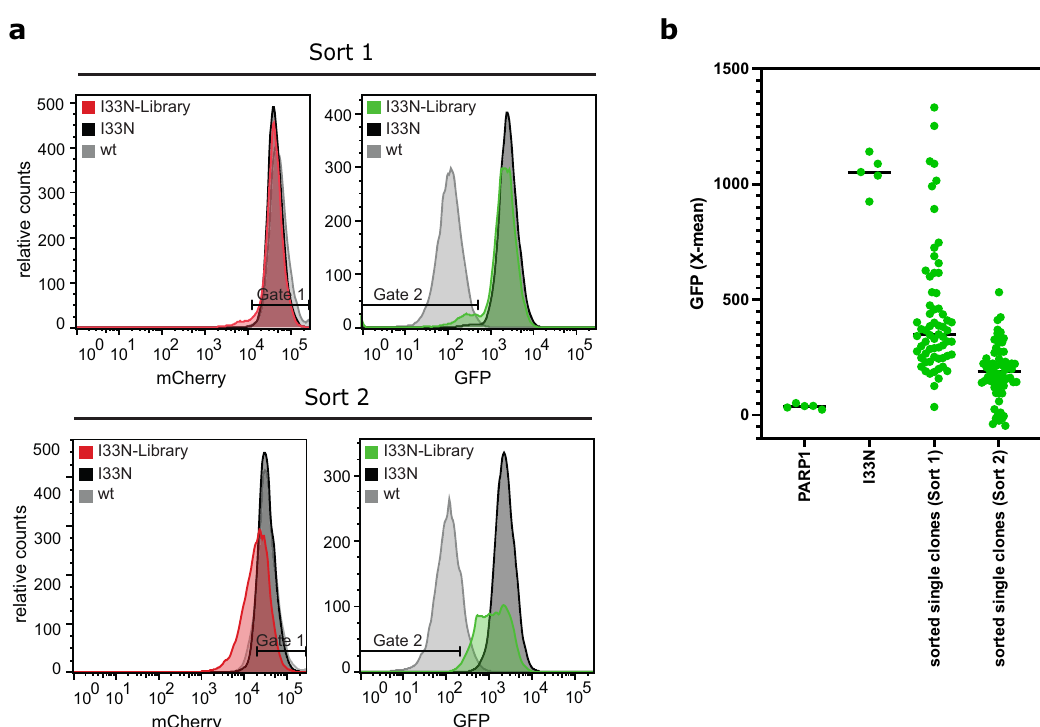
Fig. 7 Identi fi cation of protein variants with improved folding properties from a PARP1-BRCT-I33N mutant library using the dual-reporter system. A random PARP1-BRCT-I33N mutant library was co-expressed with the protein folding sensor. The cell populations were analyzed using FACS 1 h after IPTG induced protein expression. a FACS analysis of PARP1-BRCT WT, PARP1-BRCT-I33N, and the PARP1-BRCT-I33N mutant library, where the mCherry signal correlates with the translation level of PARP1-BRCT, while the GFP fl uorescence is a measure of folding properties. Two gates were de fi ned for sorting populations with high translation (Gate 1) and low GFP fl uorescence (Gate 2), thus with improved folding properties compared to PARP1-BRCT-I33N. A shift is observed in GFP signal distribution and intensities between the two rounds of sorting, showing that it is possible to enrich the population with low GFP clones after multiple rounds of sorting. b Single clones analyzed after each round of sorting, resulted in 1.5% or 12.5% of the clones overlapping with the PARP1-BRCT WT GFP signal ( n = 5 biologically independent samples for PARP1-BRCT WT, PARP1-BRCT-I33N and n = 1 for each of the 75 individual clones isolated from the library). Data are presented as individual data points with the mean value indicated. Source data are provided as a Source Data fi